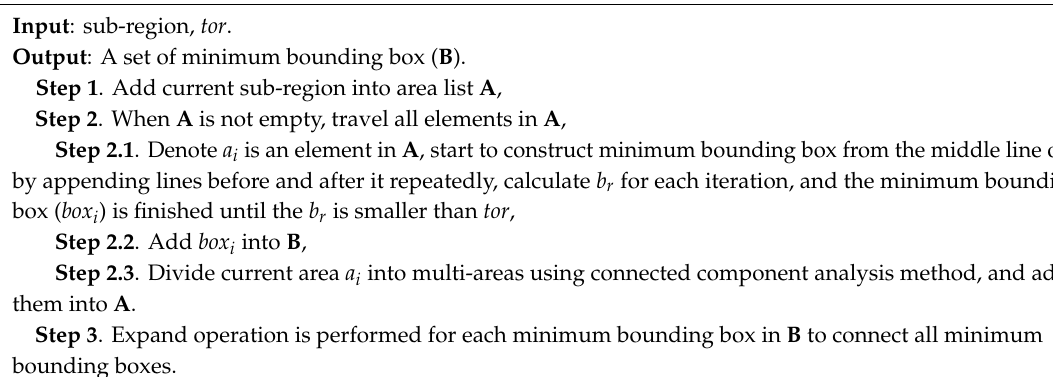
Algorithm 1 PolyBoundingBox construction algorithm for each